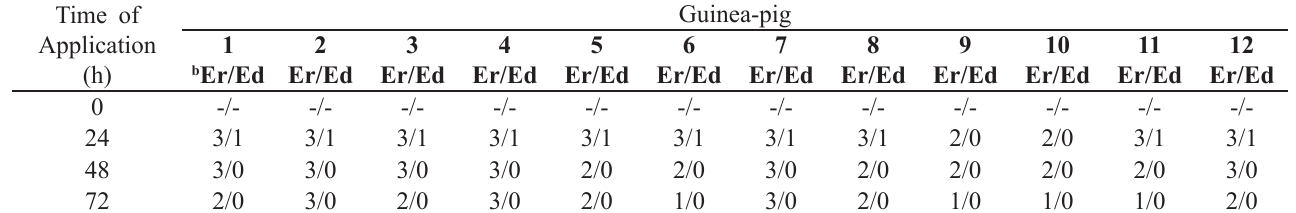
TABLE V - Edema (Ed) and Erythema (Er) measured from tests conducted after application of a chemical agent used in automobile industry a . Twelve guinea-pigs were used (1 1st to 6 th guinea-pigs with normal skin and 7 th to 12 th guinea-pig with abrased skin) a, b